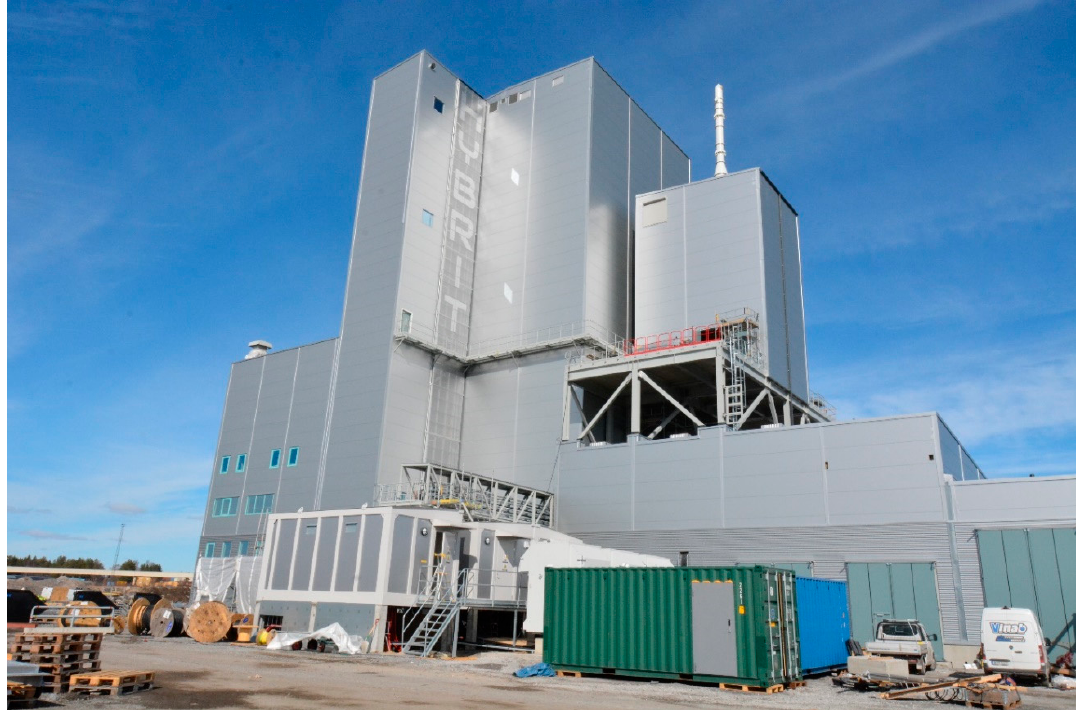
Figure 8. The pilot plant in Luleå, Sweden, under construction.